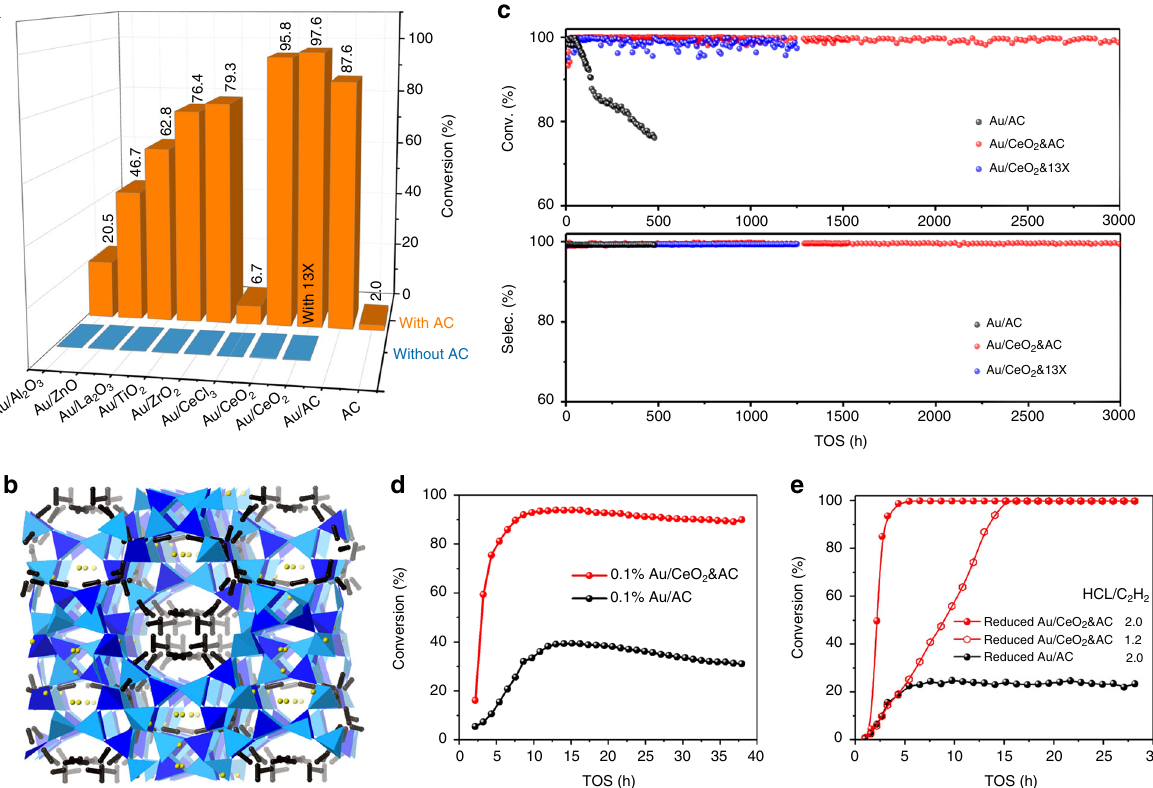
Fig. 1 Reaction results of the acetylene hydrochlorination. a Various 1% Au/metal oxides and 1% Au/metal oxides and porous materials used as catalysts. [Reaction conditions: P = 0.1 MPa, T = 180 o C, HCl/C 2 H 2 = 1.2, GHSV(C 2 H 2 ) = 720 h − 1 ]. b The re fi ned structure of the acetylene adsorbed 13X using the synchrotron X-ray powder diffraction, see Supplementary Information. c The stability test over Au/AC, Au/CeO 2 &AC and Au/CeO 2 &13X vs time on stream (TOS). [Reaction conditions: P = 0.1 MPa, T = 180 o C, HCl/C 2 H 2 = 1.2, GHSV(C 2 H 2 ) = 60 h − 1 ]. d The comparative activity of 0.1 wt% Au loading catalysts. [Reaction conditions: P = 0.1 MPa, T = 180 o C, HCl/C 2 H 2 = 1.2, GHSV(C 2 H 2 ) = 90 h − 1 ]. e Catalyst re-activation from pre-reduced Au/AC, Au/ CeO 2 &AC and Au/CeO 2 &13×. [Reaction conditions: P = 0.1 MPa, T = 180 o C, HCl/C 2 H 2 = 1.2 or 2.0, GHSV(C 2 H 2 ) = 240 h − 1